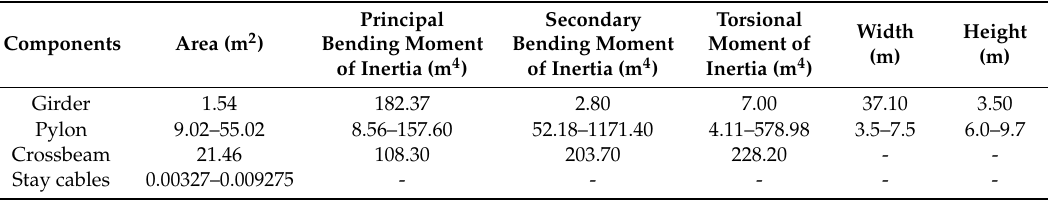
Table 3. Configurations for cross-sections of girder.